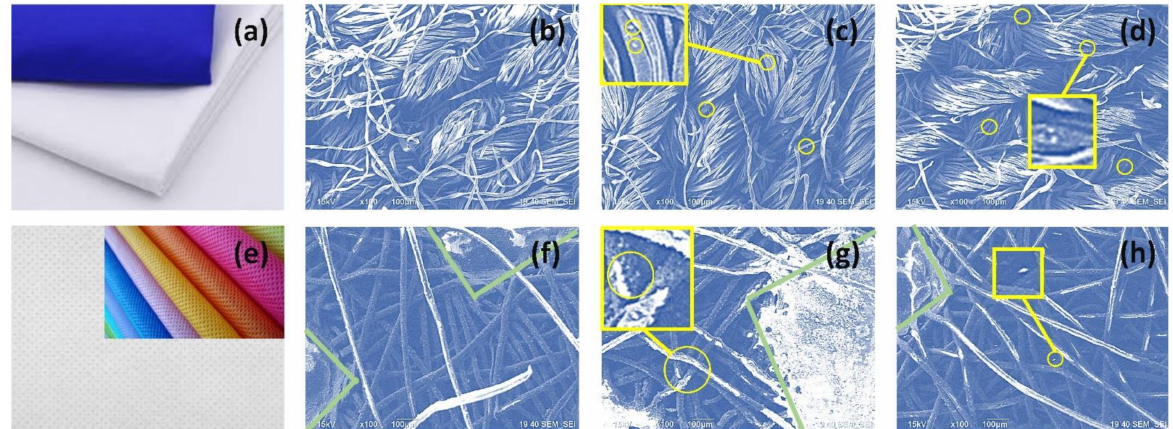
Figure 2. Fabrics used in the experiments: representative photograph of commercial F2 ( a ), mi- crograph of clean F2 ( b ), FAU-modified F2 (X-F2) ( c ), LTA-modified F2 (A-F2) ( d ), representative photograph of commercial F4 ( e ), micrograph of clean F4 ( f ), FAU-modified F4 (X-F4) ( g ), LTA- modified F4 (A-F4) ( h